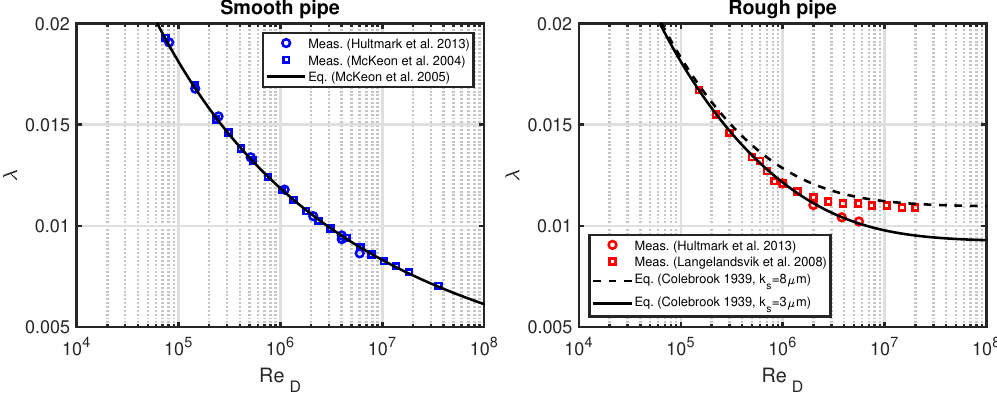
Figure 7. Friction factors, left: Smooth pipe, right: Rough